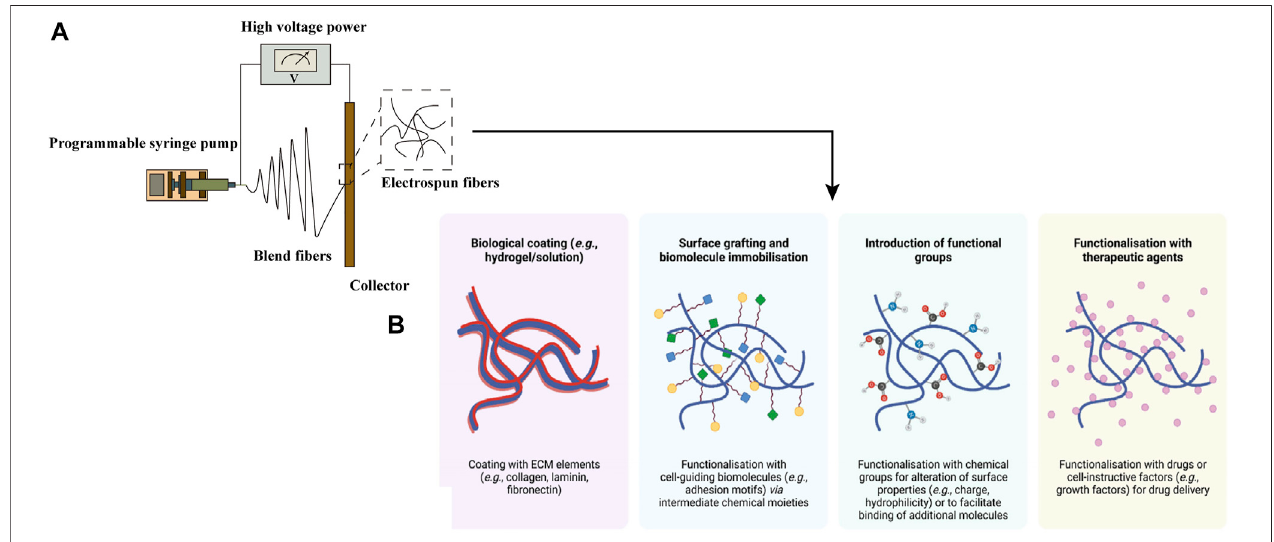
FIGURE 4 | Electrospun fi bers, obtained by basic electrospinning setup (A) , can be modi fi ed by physical or chemical techniques. Post-fabrication surface modi fi cations of electrospun fi bers (B) were adapted with permission from ref (Gonçalves et al., 2021). Copyright 2021 by MDPI Inc.